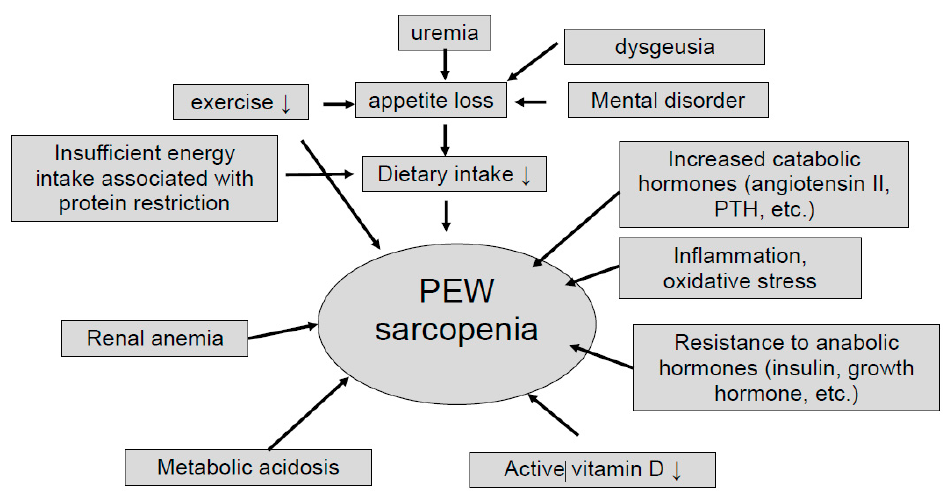
Figure 1. Potential causes of protein-energy wasting and sarcopenia. PEW; protein energy wasting, PTH; parathyroid hormone.